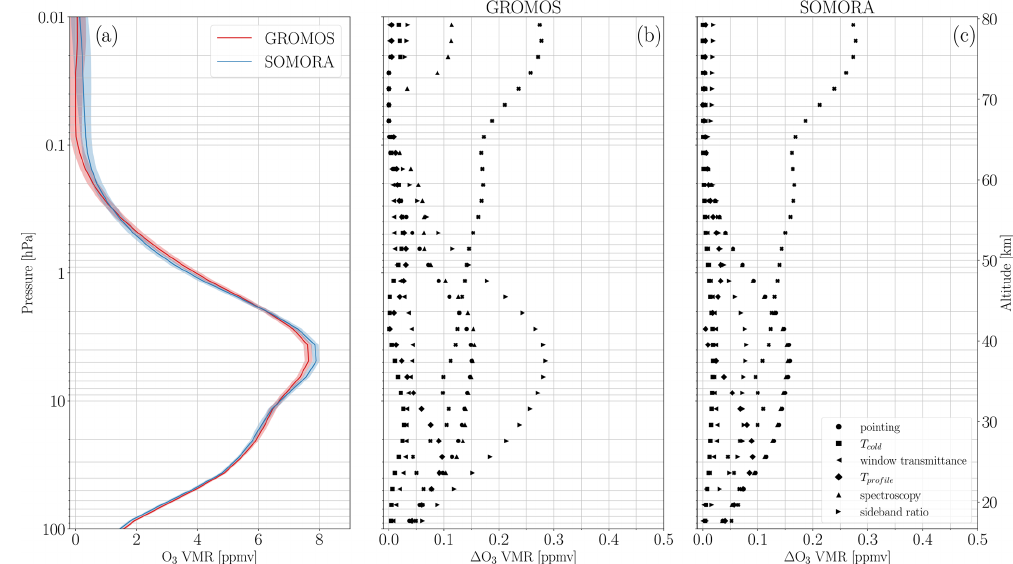
Figure 4. Uncertainty budget for GROMOS and SOMORA in a low-opacity case ( τ ≈ 0 . 15). Panel (a) shows the reference ozone profile chosen for the sensitivity analysis. Panels (b) and (c) show the ozone VMR uncertainties arising from the error sources listed in Table 3.